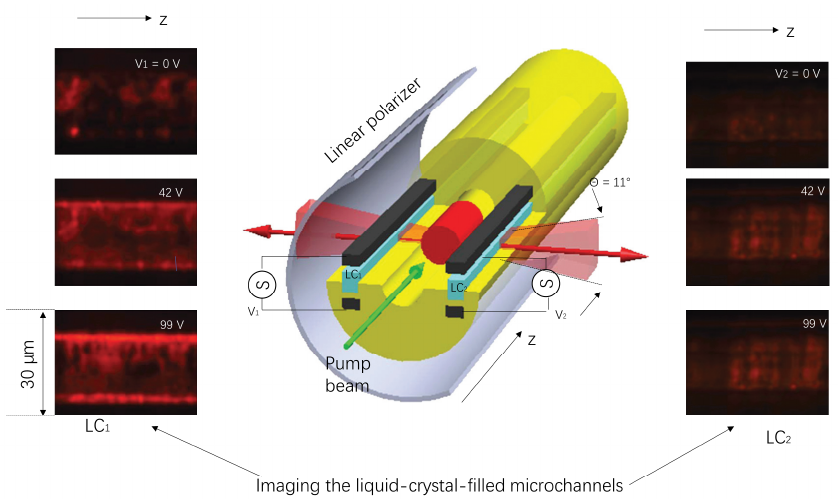
Figure 4. Schematic of zero-angle momentum microcavity lasers based on hollow Bragg optical fibers